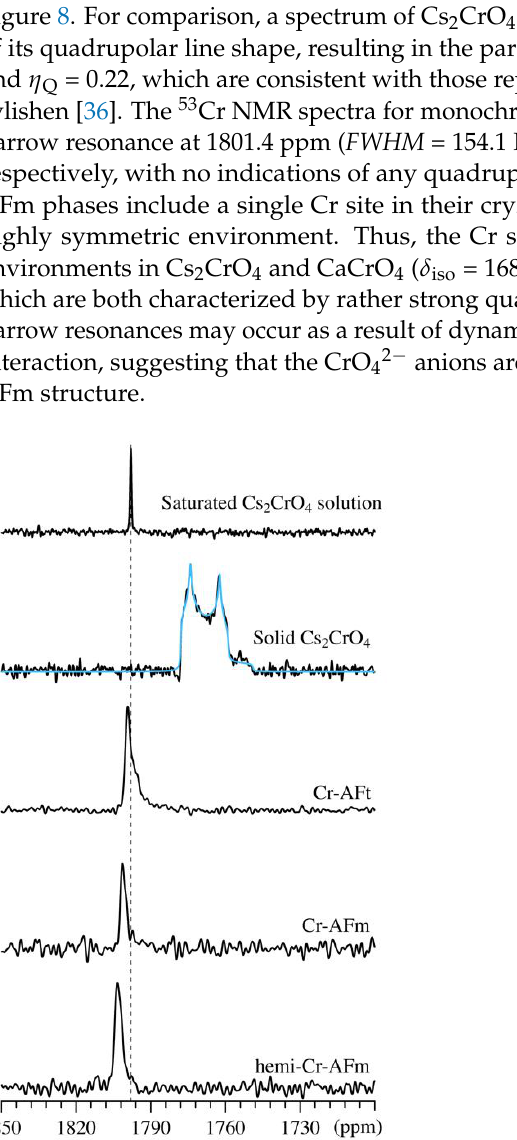
Figure 8. 53 Cr MAS NMR spectra (22.3 T) of the central transitions for chromate AFt, monochromate, hemichromate, and a solid sample of Cs 2 CrO 4 acquired with a spinning frequency of ν R = 12.0 kHz and a relaxation delay of 2 s. A saturated Cs 2 CrO 4 solution was used as the external chemical-shift reference, which is observed at δ iso = 1798 ppm relative to the standard reference of a saturated solution of Cr(CO) 6 dissolved in CDCl 3 . The blue line shows the simulated quadrupolar line shape of the 53 Cr resonance for Cs 2 CrO 4 , corresponding to the parameters δ iso = 1781 ppm, C Q = 1.21 MHz and η Q = 0.22.